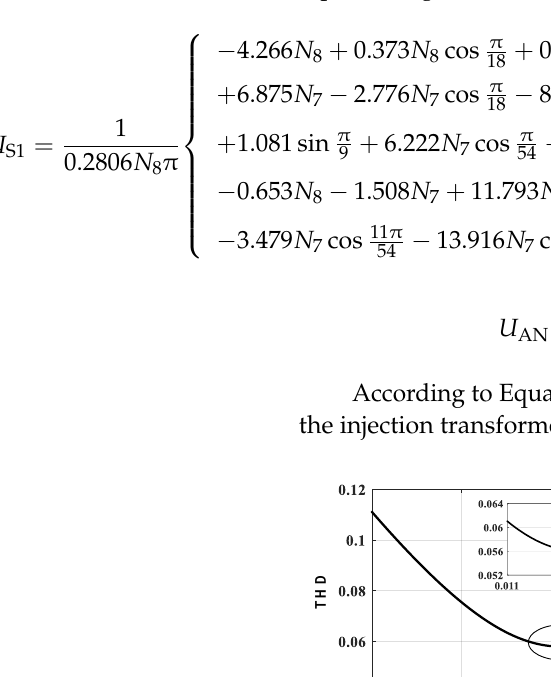
Table 1. Expressions of Voltage u AN with the harmonic suppression method.